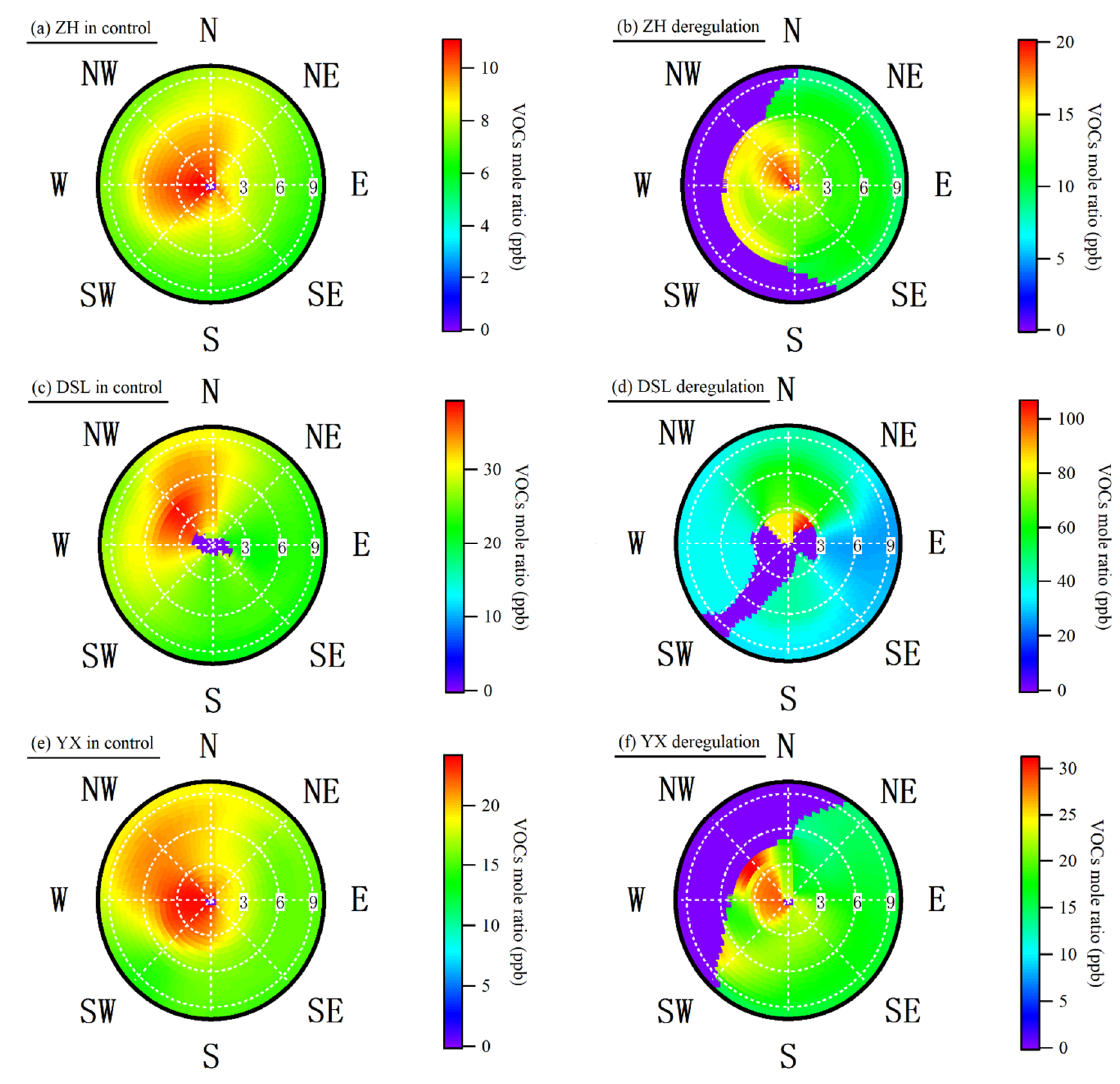
Figure 10. Wind analysis results using non-parametric wind regression (NWR) on VOCs mole ratios measured at the ZH (( a ) in control, ( b ) deregulation), DSL (( c ) in control, ( d ) deregulation) and YX (( e ) in control, ( f ) deregulation) sites during different periods of the G20 Summit.